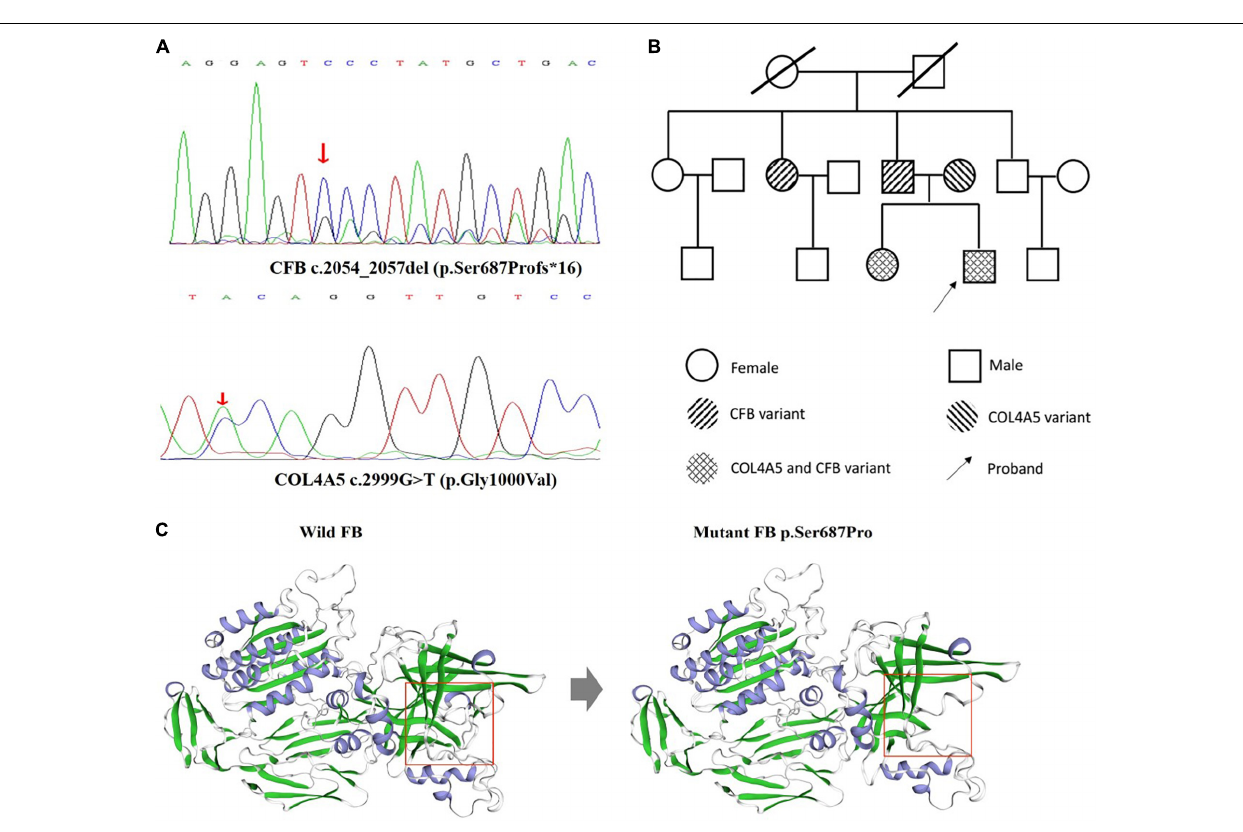
Frontiers in Genetics |